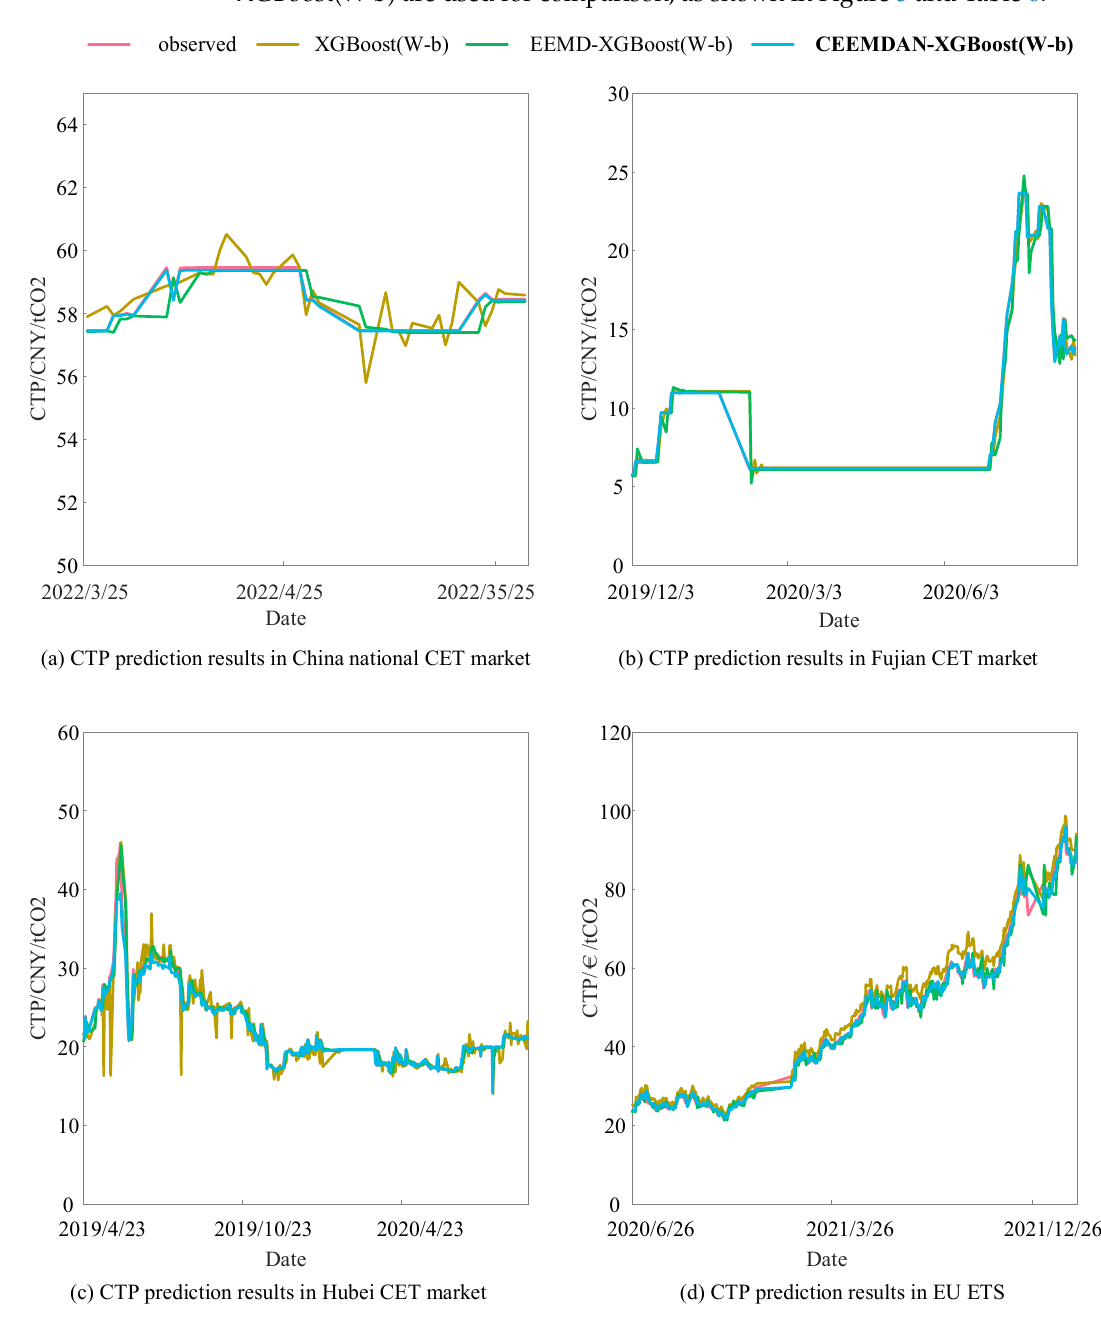
Figure 5. CTP prediction results for different decomposition methods. Table 6. The error of the forecasting models based on different decomposition methods. China’s National CET Market